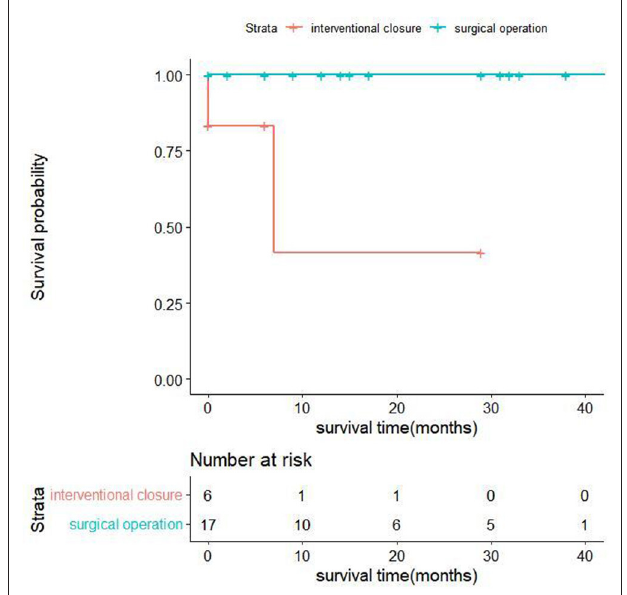
FIGURE 2 | Kaplan-Meier estimates of cumulative event-free survival for long-term mortality.